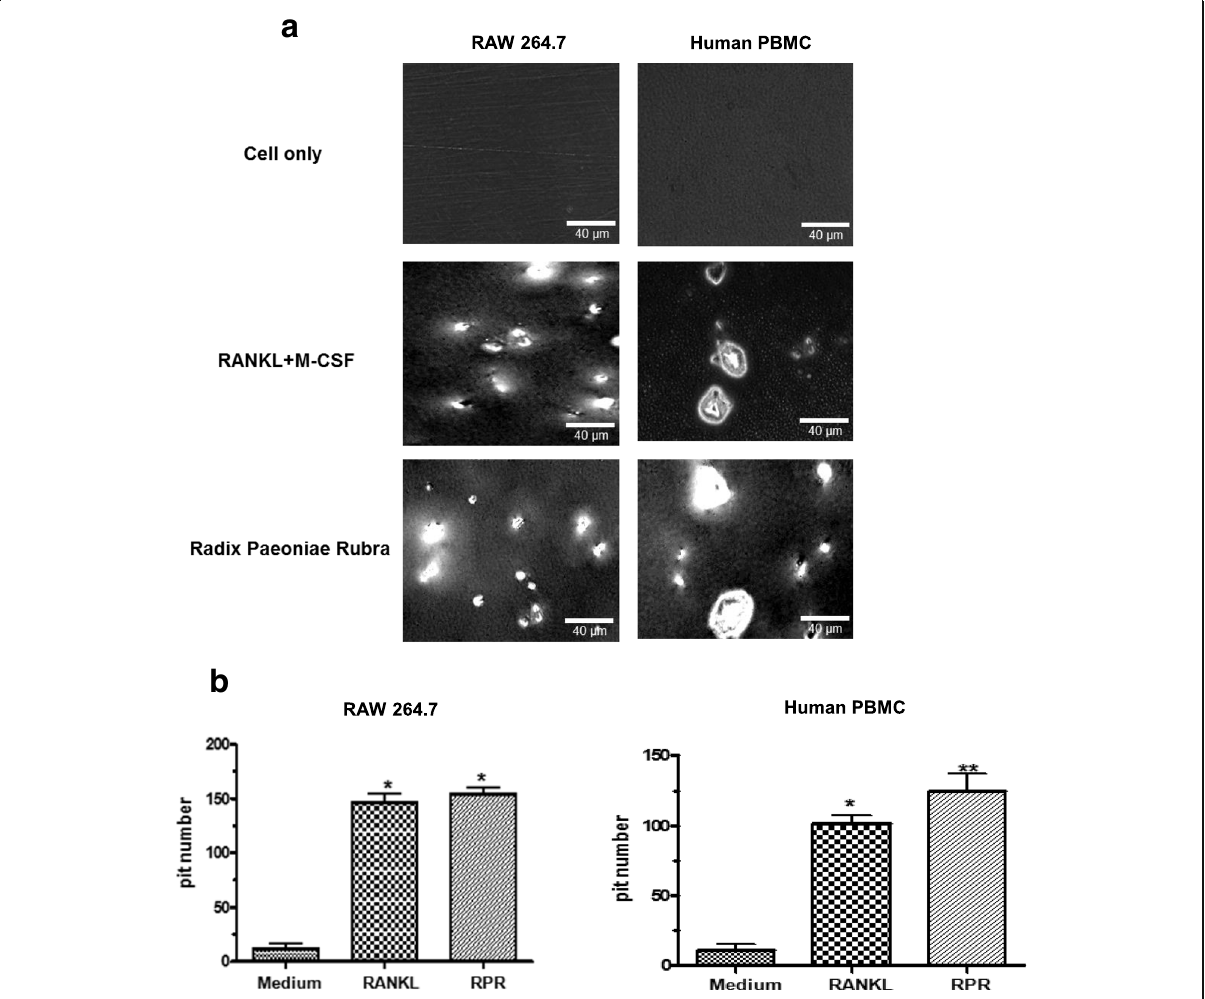
Fig. 4 RPR-induced bone resorption activity for osteoclasts. a Human PBMCs or murine RAW264.7 macrophages were placed on a synthetic bone cell culture and then treated with RANKL and M-CSF or RPR. After 7 or 14 days of culture, cells were separated. Microscopy was used to determine the number of pits in each well, which were photographed. b Data are the mean ± SD from three independent tests; * p < 0.01, ** p < 0.001, compared with the medium as the singular